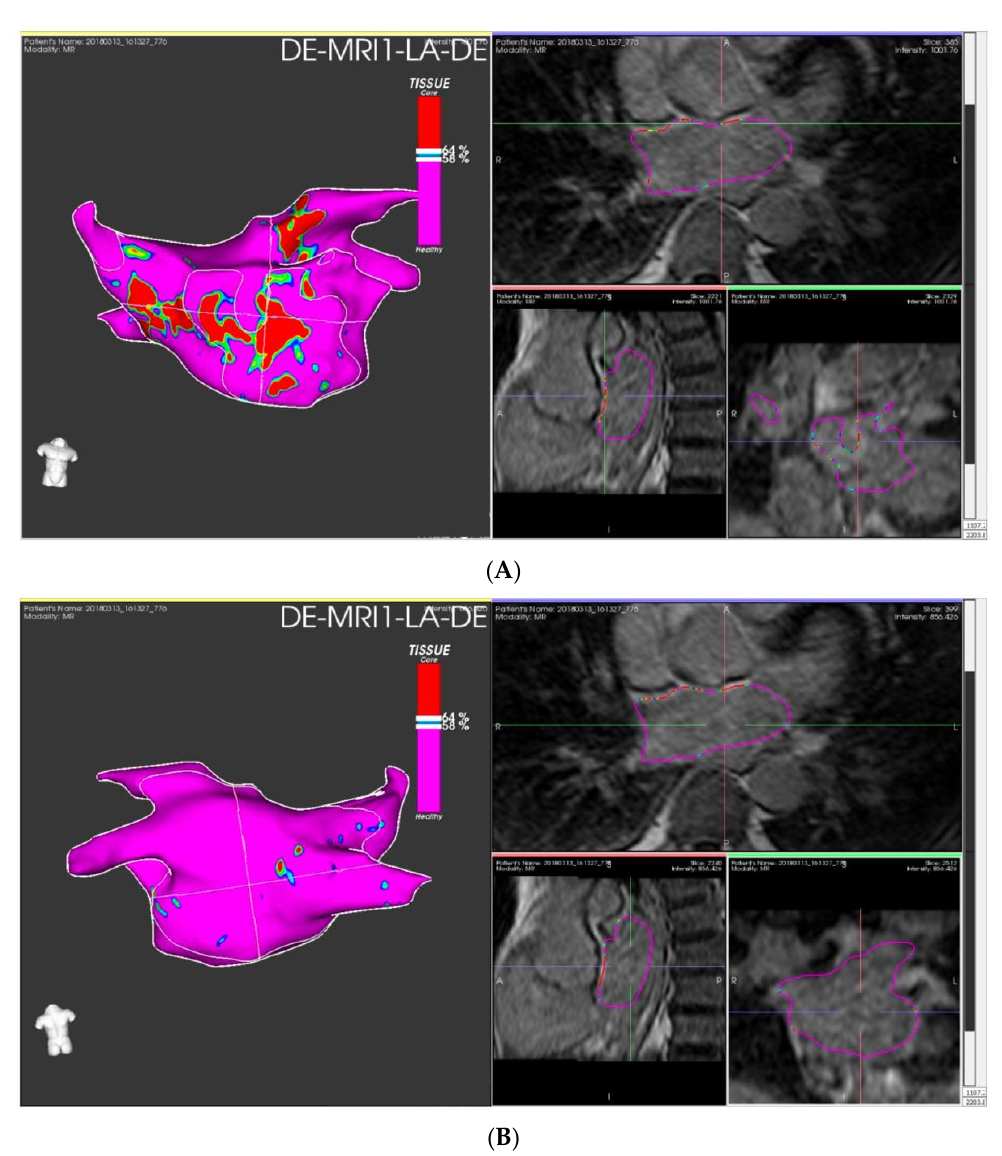
Figure 4. Left atrial fibrosis staging with LGE-CMR images elaborated with ADAS 3D TM (ADAS3D Medical, Barcelona, Spain) before catheter ablation: Panel ( A ) anterior LA wall; panel ( B ) posterior LA wall. Estimated fibrosis: 12%, Utah stage